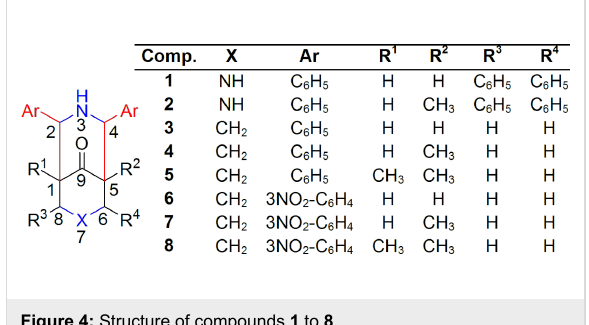
Figure 4: Structure of compounds 1 to 8